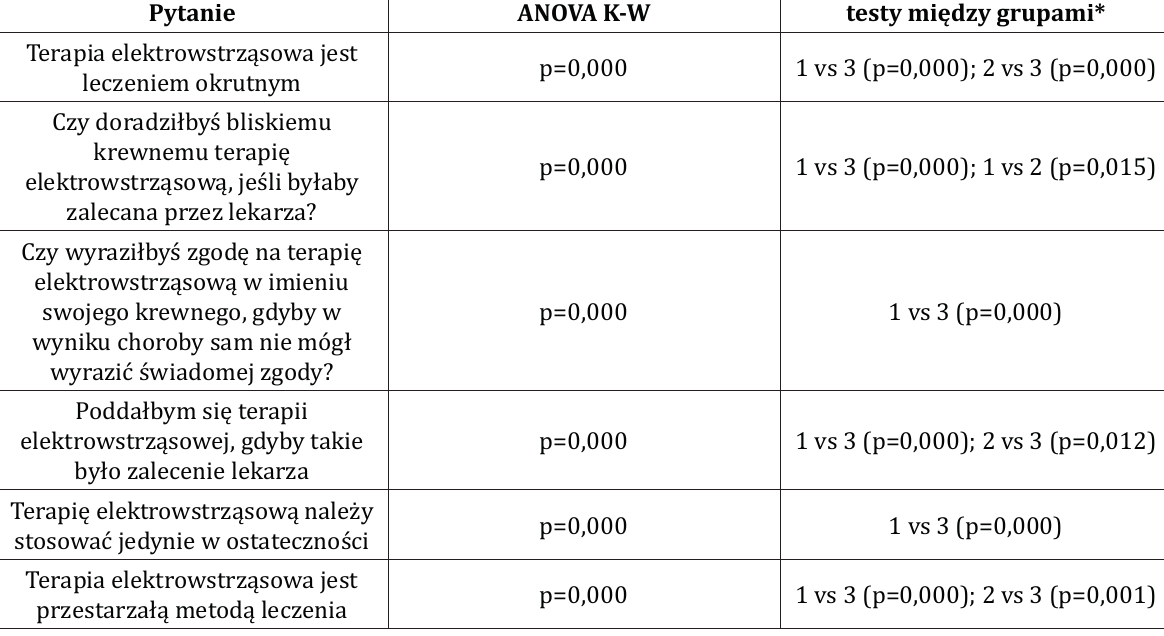
Tabela 3. Potwierdzenie statystyczne różnic dotyczących postaw wobec terapii elektrowstrząsowej w zależności od kierunku